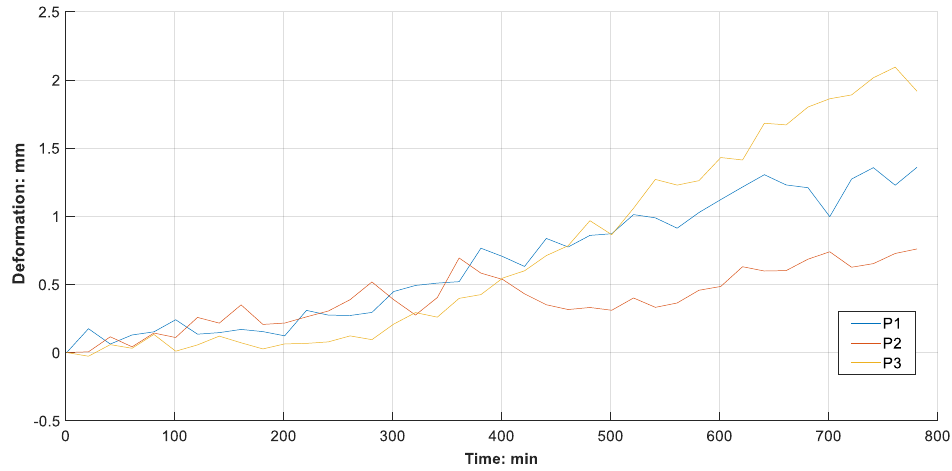
Figure 23. Real time processing method for deformation curves.